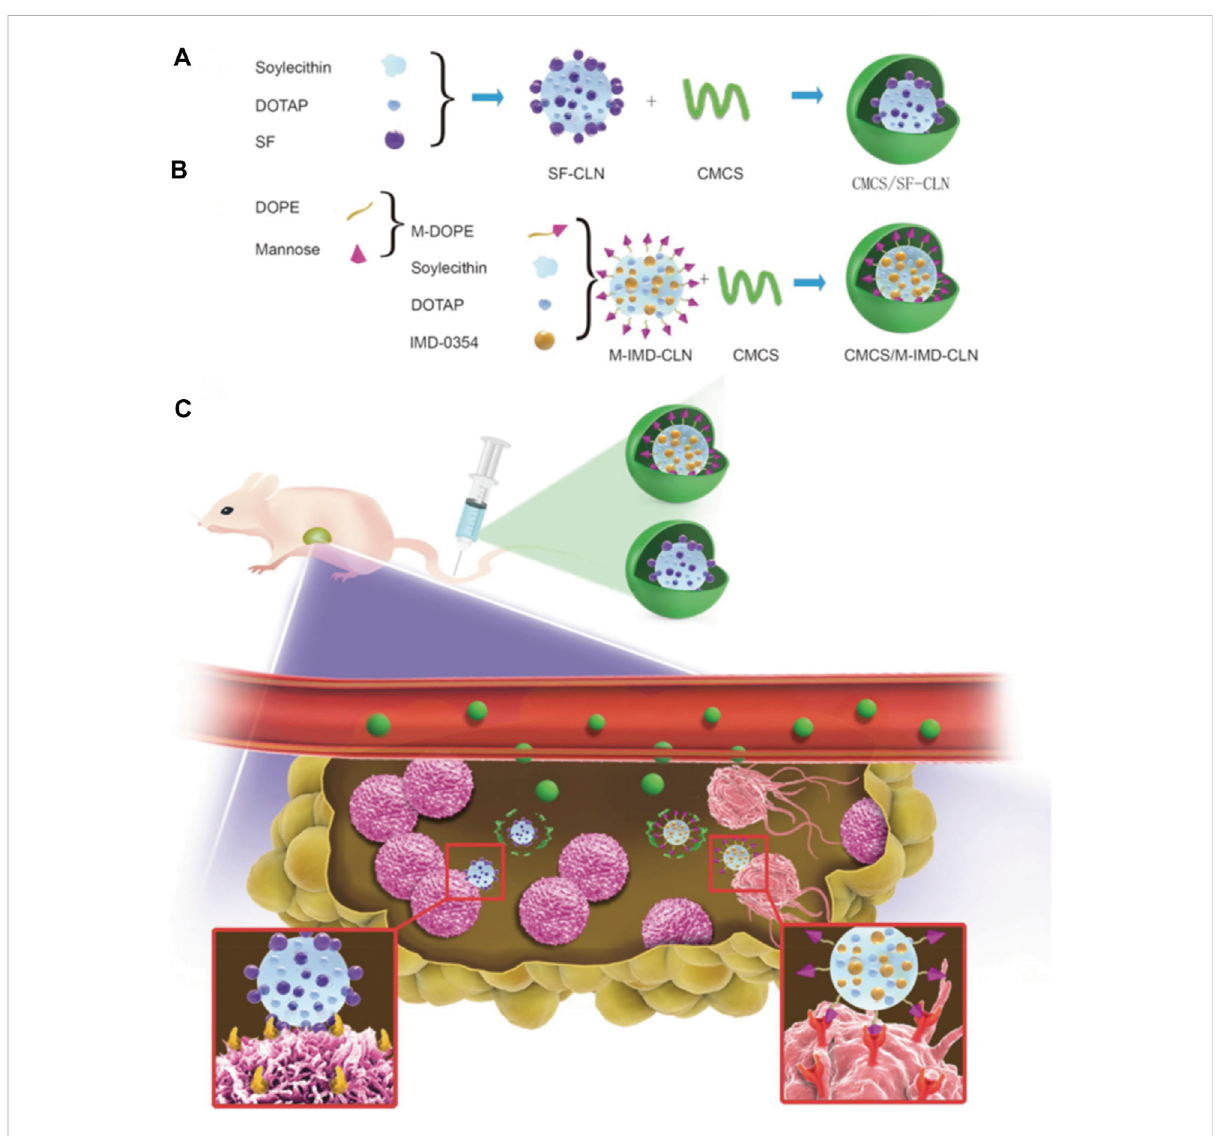
FIGURE 9 (A – C) Scheme of twin-like core-shell nanoparticles (CMCS/SF-CLN + CMCS/M-IMD-CLN) for synchronous biodistribution and targeted delivery to enhance chemo-immunotherapy (Wang et al.,